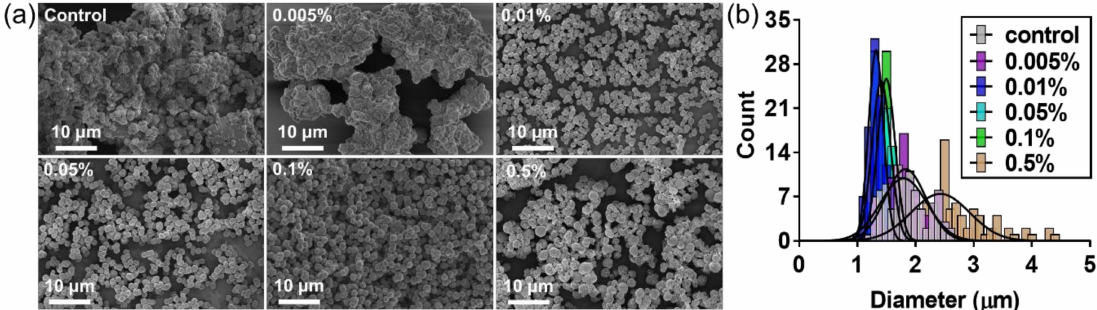
Figure 1. SEM image ( a ) and histogram of particle size distribution ( b ) of L-AMPs formed with varying concentration of lecithin from 0.005% to 0.5% (w/v). The amylose-based microparticles (AMPs) formed without lecithin were used as a